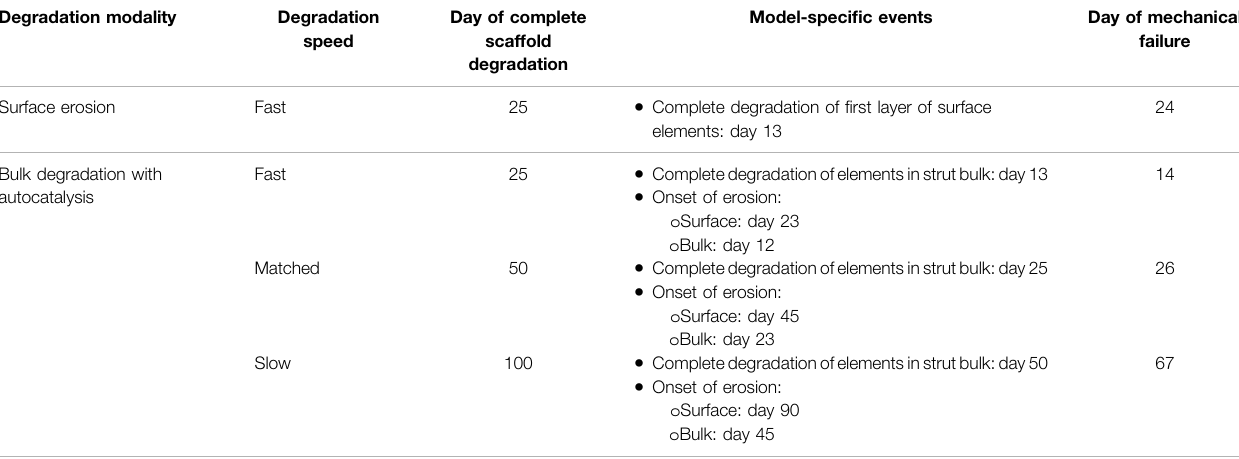
TABLE 6 | Models for which the mechanical failure of the scaffold prior to complete defect repair was